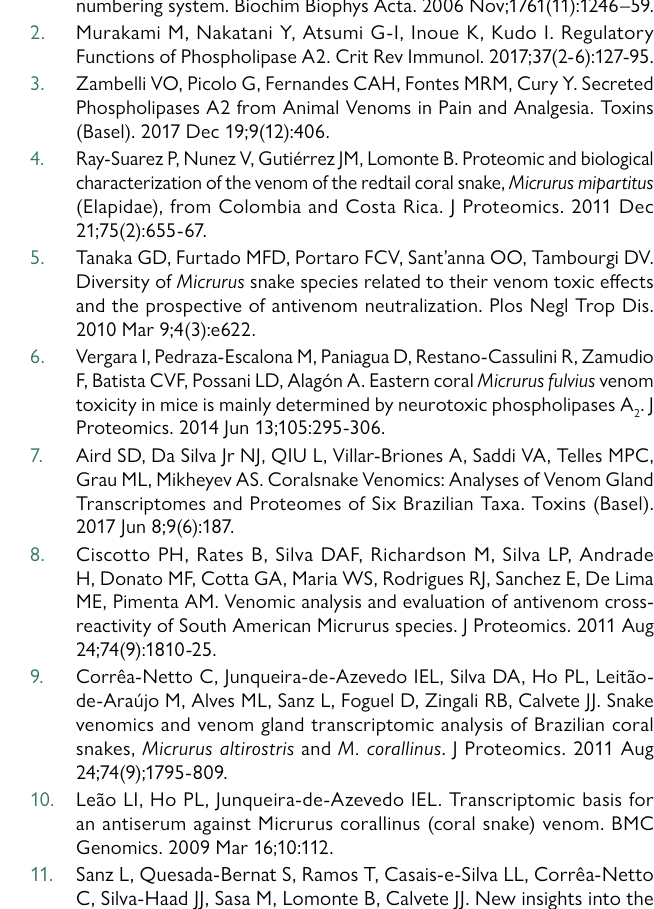
table and error map. (C) Annotated spectrum with alignment of the ion 569.24 2+ and its (D) ion